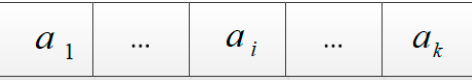
Figure 4. The chromosome